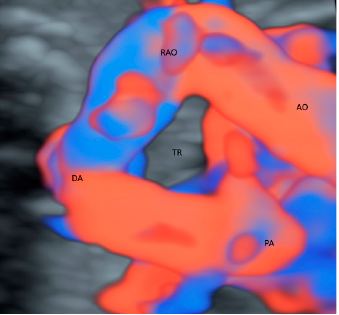
Figure 1. Glass-body rendering mode with high-definition Doppler showing a fetus with right aortic arch at 36 weeks’ gestation. Noted that the trachea (TR) is surrounded by Aorta (AO), right aortic arch (RAO), pulmonary artery (PA) and ductus arteriosus (DA).